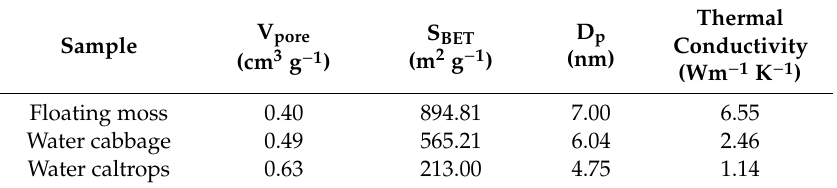
Table 2. Textural characterization for the silicon oxycarbide (SiOC) samples.